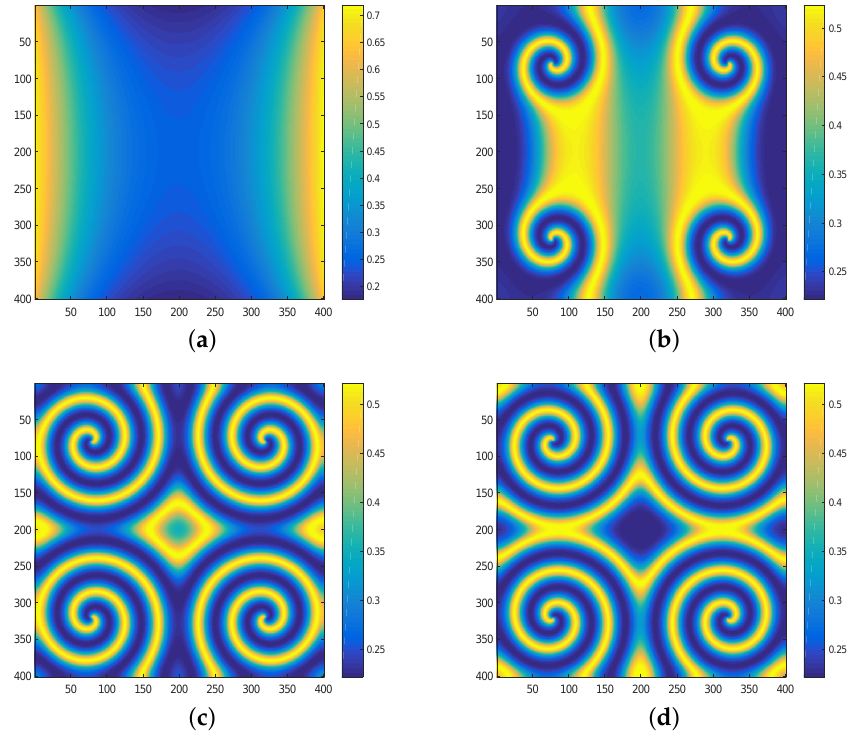
Figure 12. The spiral pattern formation process of the model (3), the parameters are given by (41). Times: ( a ) t = 0, ( b ) t = 3000, ( c ) t = 8000, and ( d ) t =